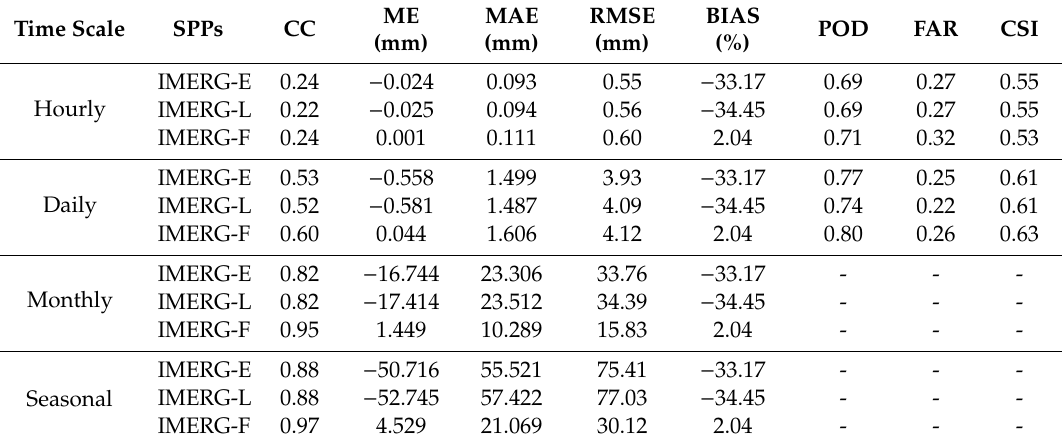
Table 3. Summary of statistical metrics of precipitation estimates from integrated multisatellite retrievals for Global Precipitation Measurement (IMERG) SPPs at hourly, daily, monthly, and seasonal